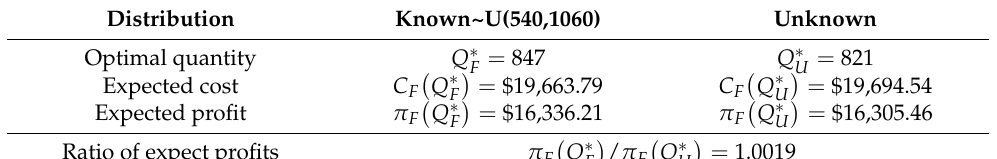
Table 3. Order quantity, expected profit and cost depending on demand distribution availability.